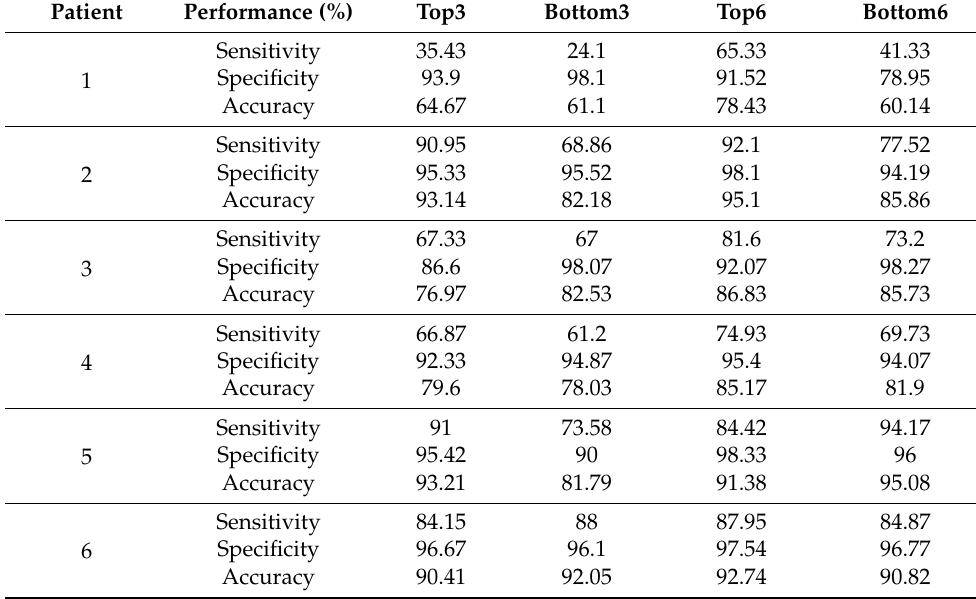
Table A1. Performance of CGRU with channel reduction based on attention